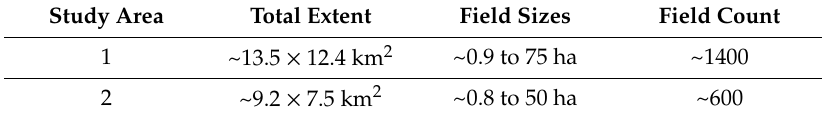
Table 1. Field statistics in the two regions of interest based on the updated reference datasets.